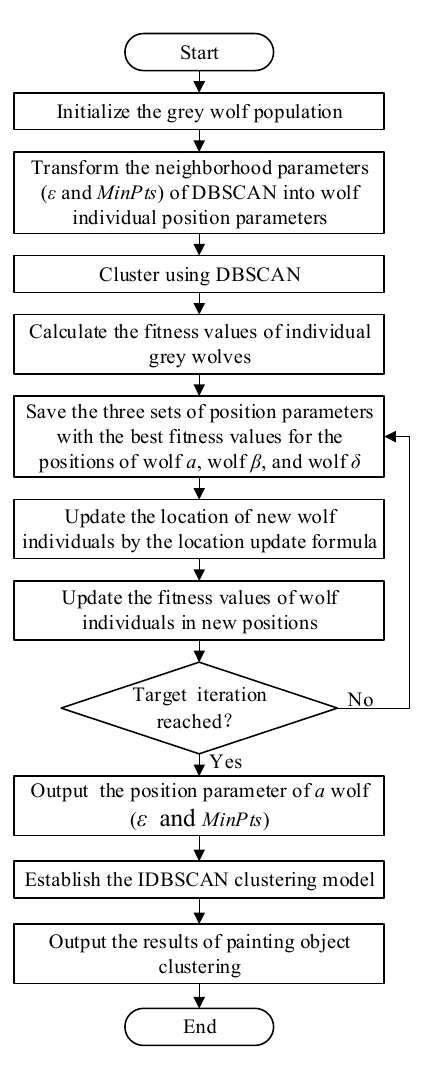
Figure 2. Algorithm flow of clustering model based on IDBSCAN. The steps are as follows.